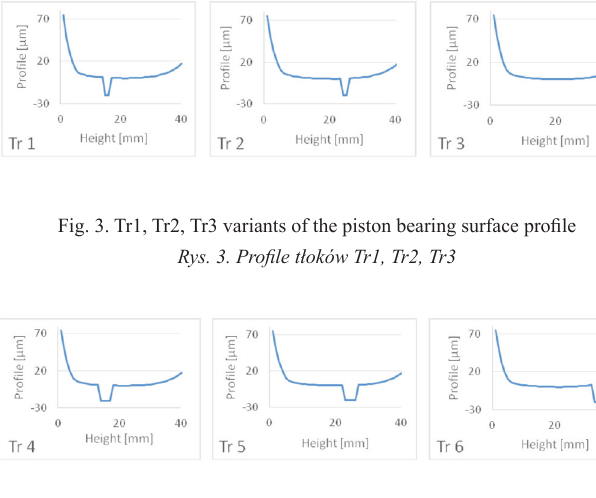
Fig. 4. Tr4, Tr5, Tr6 variants of the piston bearing surface profile Rys. 4. Profile tłoków Tr4, Tr5,